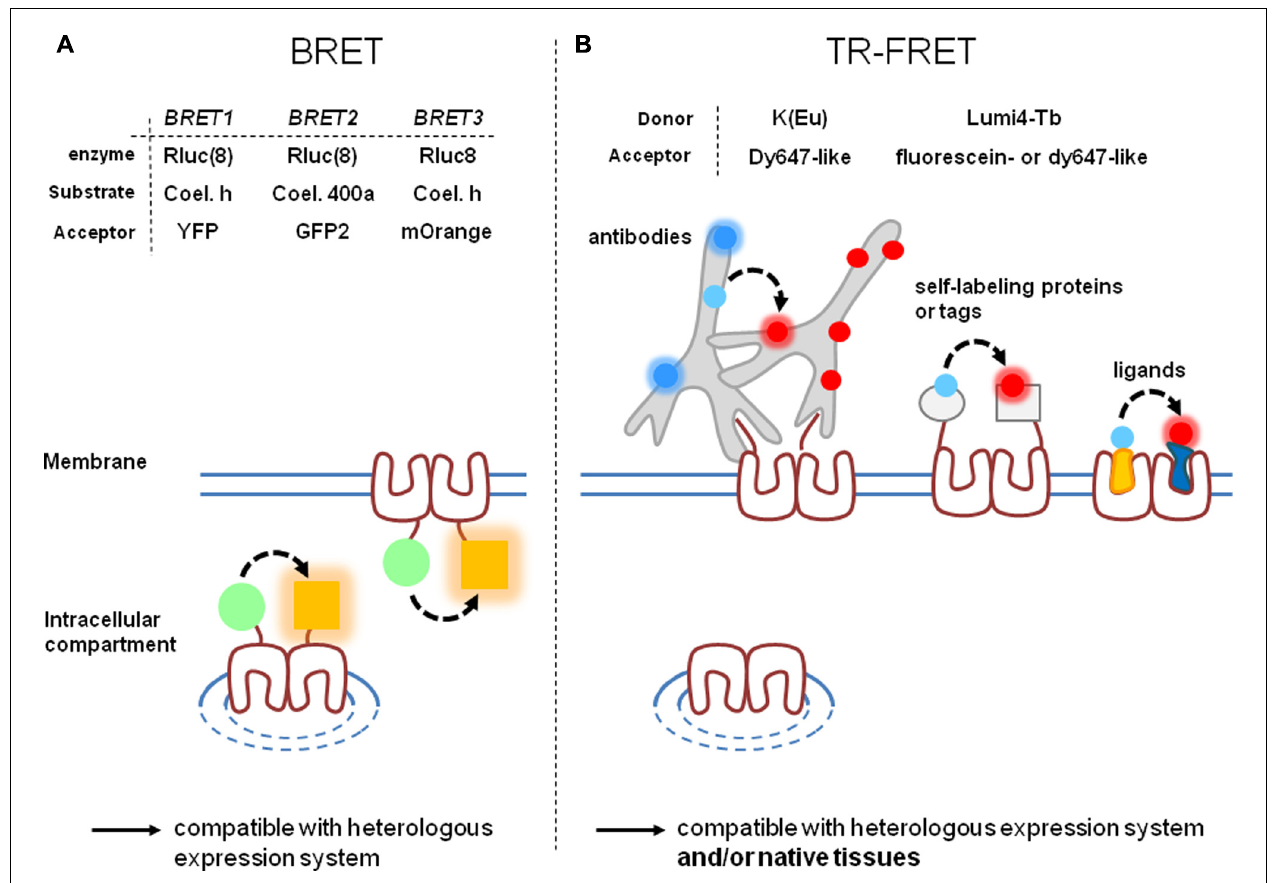
targeted receptors.Variants ofTR-FRET depending on the fluorescent carrier have been developed. (B) TR-FRET opens the possibility to discriminate receptor targeted to the cell surface from those trapped in intracellular compartments.TR-FRET is also more adaptable to different cellular contexts and is the only one to be compatible with receptors expressed in a native context. [Rluc(8), Rluc or Rluc8; Coel. h, Coelenterazine h; Coel. 400a, Coelenterazine 400a (also known as